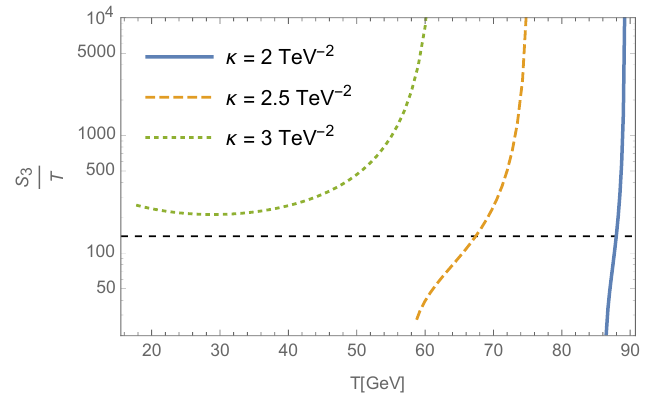
Figure 2 . S 3 =T as a function of temperature for three values of (cid:20) . The horizontal line indicates S 3 =T = 140, the approximate value for which bubbles nucleate. The graph shows that nucleation is impossible for (cid:20) & 3 TeV (cid:0) 2